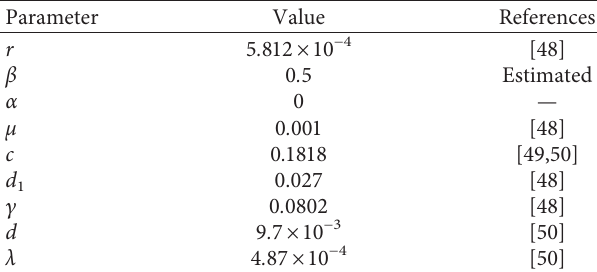
Table 2: Parameter estimation for the